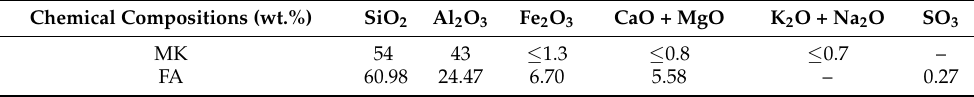
Table 1. The chemical compositions of MK and FA.